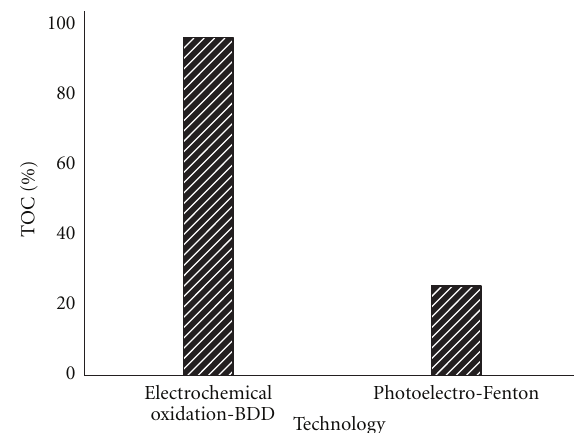
Figure 5: TOC values after 120 minutes of reaction time employing the photo-electron-Fenton process, using carbon fiber modified with TiO 2 in the presence of 120 mgL − 1 of H 2 O 2 and 0.5 mM Fe(SO 4 ) 2 at pH 3, with an application of radiation at 365 nm with a lamp of 0.71 μ Wcm − 2 . The solution was pre-saturated with